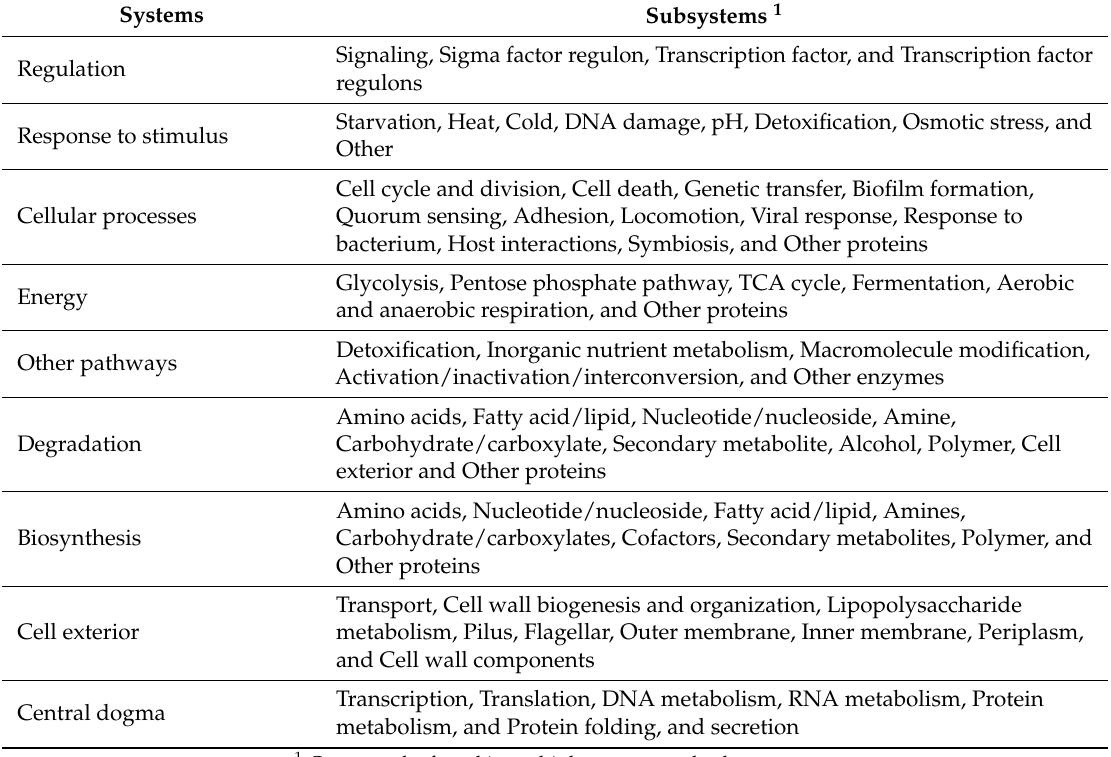
Table A1. The Gallium(III) (Ga) resistant and sensitive hits were surveyed against the EcoCyc database permitting the clustering of the hits into systems, subsystems, component subsystems, and lastly into individual